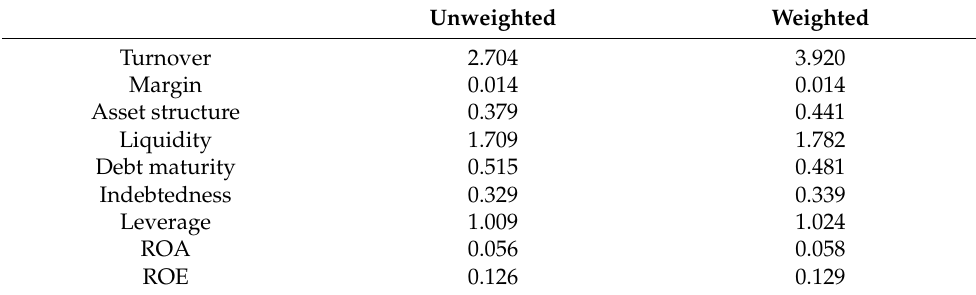
Table 7. Maximum difference between cluster centers in weighted and unweighted cluster